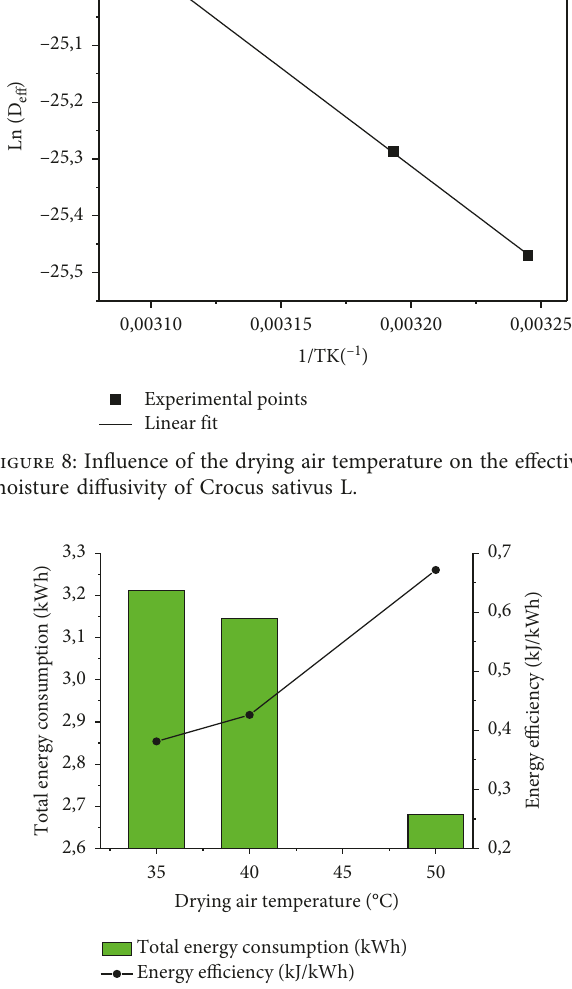
Figure 9: The variation of the total energy consumption and the energy efficiency as depending on the drying air